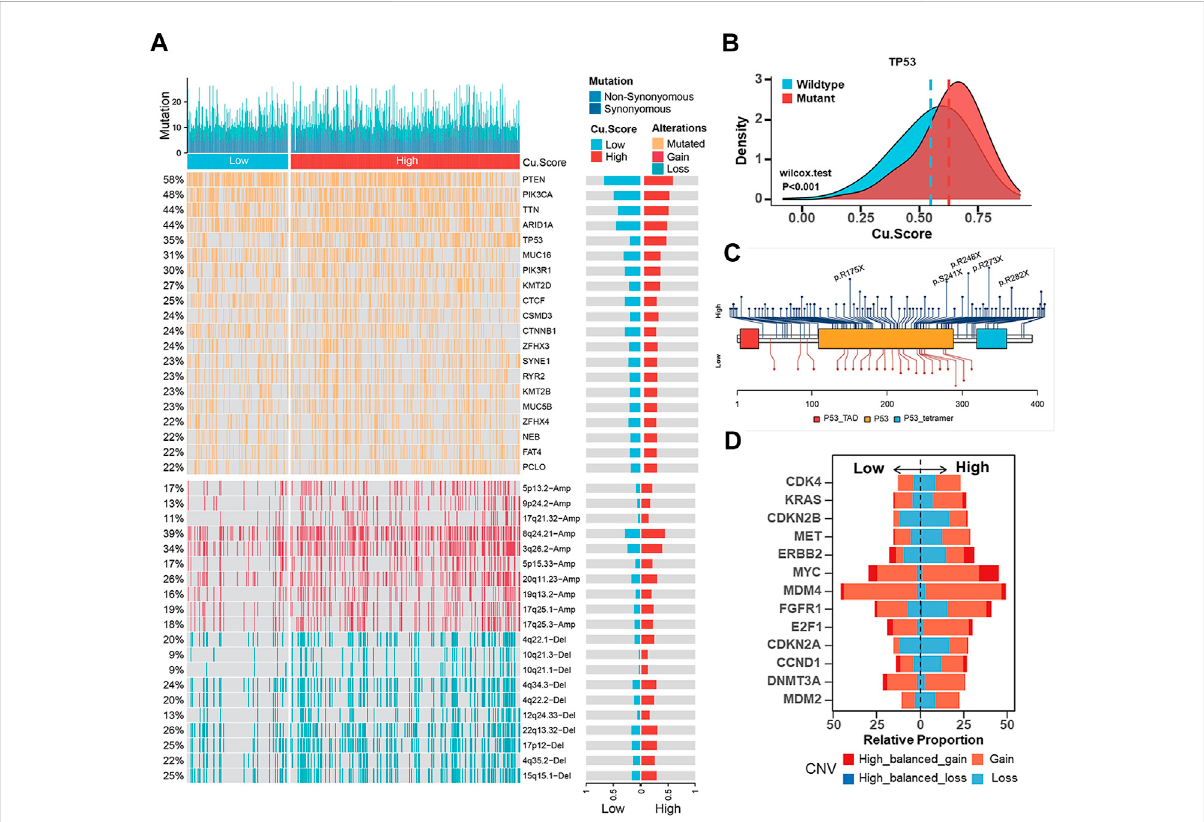
FIGURE 6 Estimation of genetic alterations in high- and low-Cu. Score subgroups (A) . Comparisons of somatic mutations (The top half) and CNAs (The bottom half) between different Cu. Score subgroups. (B) The difference of Cu. Score between the TP53 mutant group and the TP53